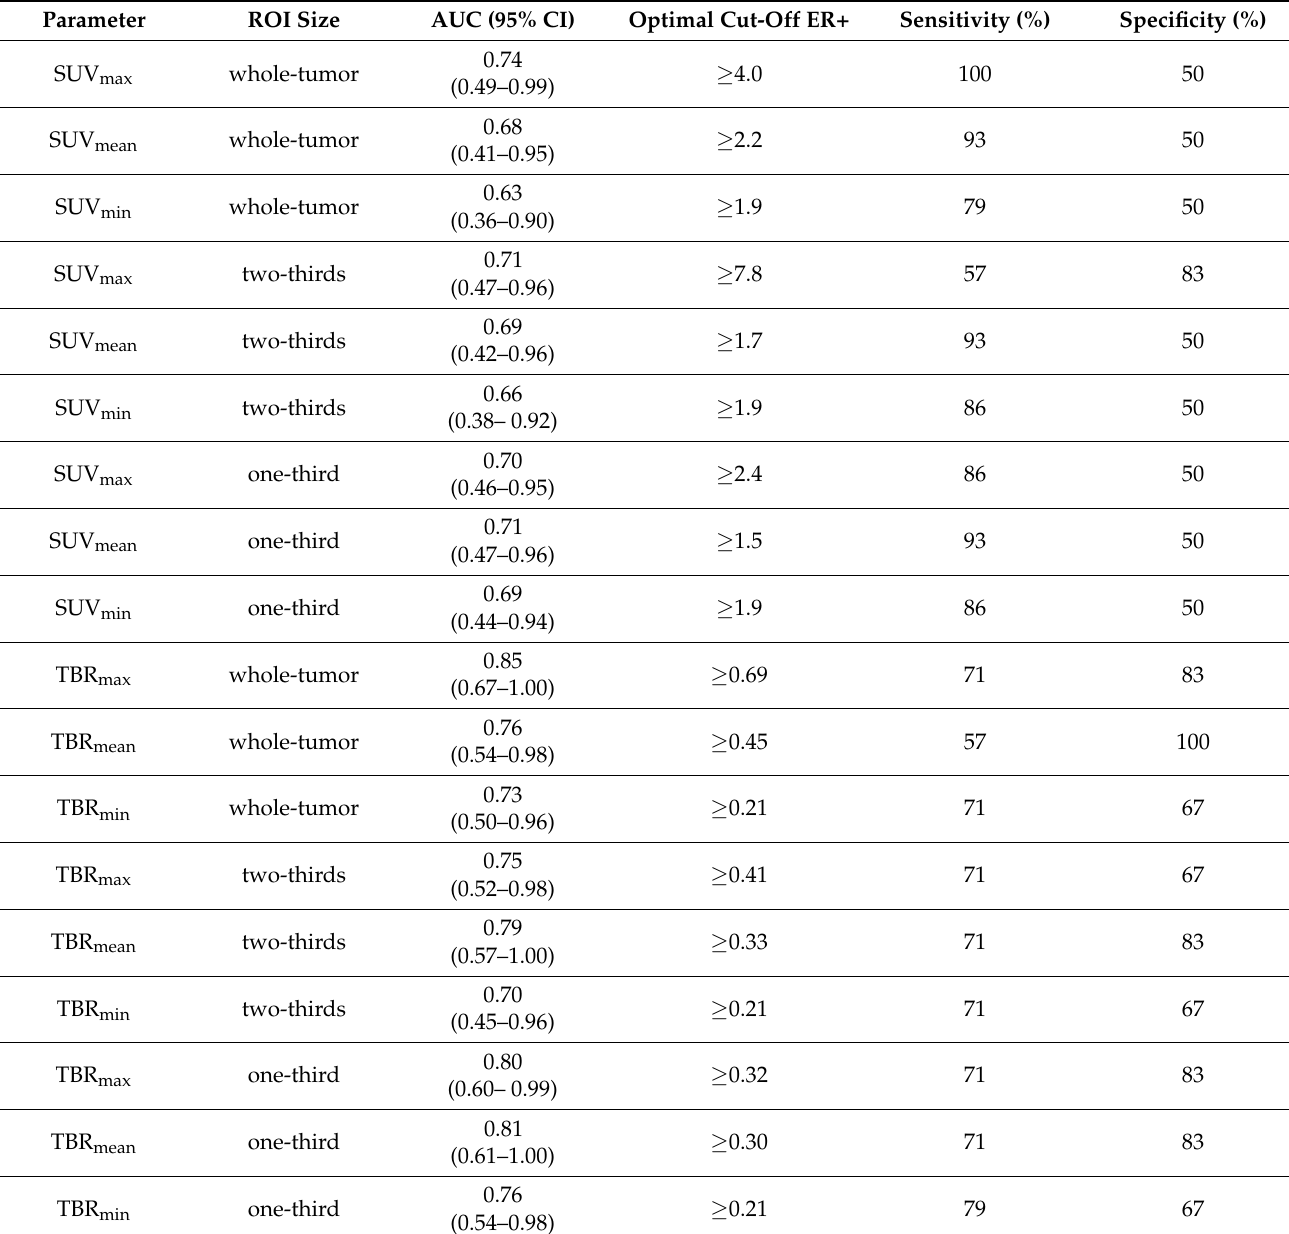
Table A4. The discriminative power of [ 18 F]-FES-PET to stratify liver metastases by ER status ( n = 20 metastases with a longest diameter ≥ 2